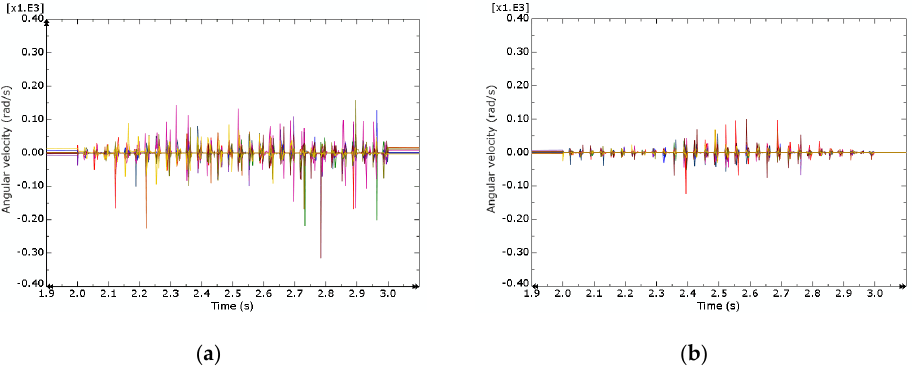
Figure 6. Angular velocity of different mixtures: ( a ) AC 11 in X-direction; ( b ) PA 11 in X-direction.